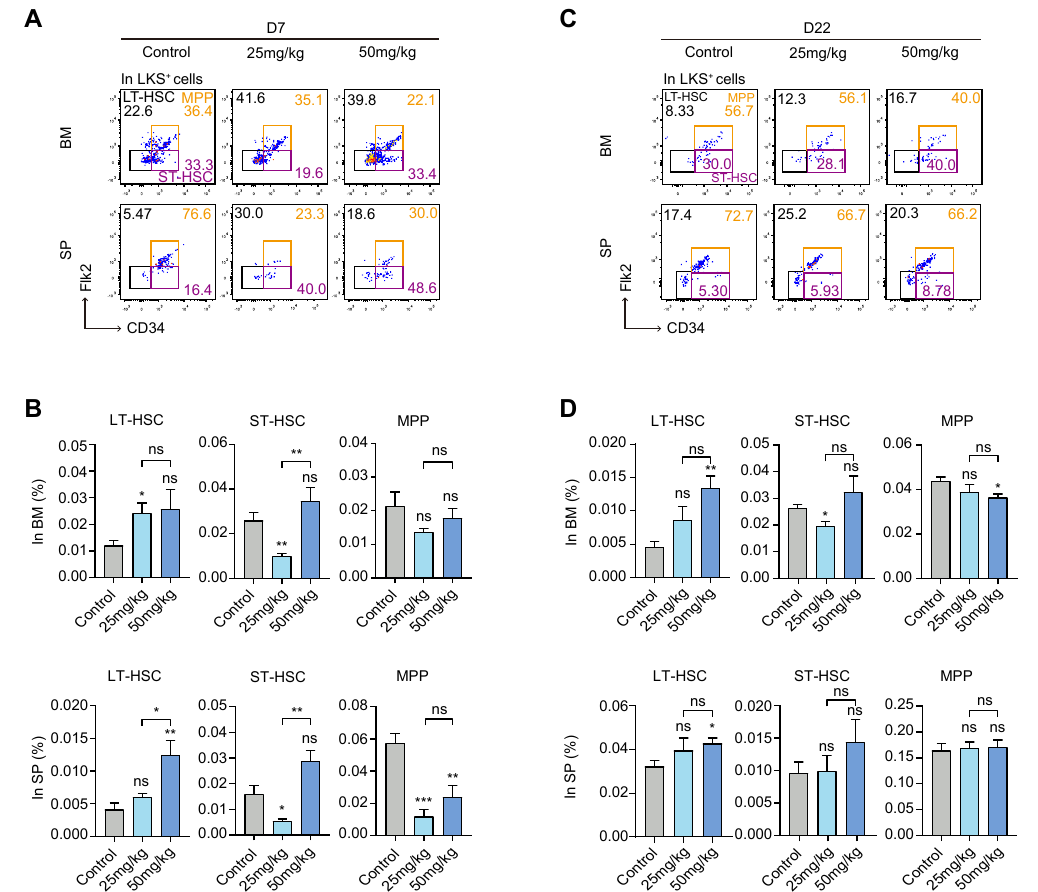
Figure 2. Effects of S63845 treatment on the hematopoietic stem/progenitor cells of CB6F1 mice. ( A ) Representative FACS profiles of LT-HSC, ST-HSC, and MPP subpopulations in BM and SP LKS + cells of control and S63845-treated mice on day 7. Control, n = 5; 25 mg/kg, n = 5; 50 mg/kg, n = 4. ( B ) Percentage of LT-HSC, ST-HSC, and MPP populations in BM (upper panel) and SP (lower panel) LKS + cells, as described in ( A ). Control, n = 5; 25 mg/kg, n = 5; 50 mg/kg, n = 4. ( C ) Representative FACS profiles of LT-HSC, ST-HSC, and MPP subpopulations in BM and SP LKS + cells of control and S63845-treated mice on day 22. Control, n = 6; 25 mg/kg, n = 5; 50 mg/kg, n = 4. ( D ) Percentage of LT-HSC, ST-HSC, and MPP populations in BM (upper panel) and SP (lower panel) LKS + cells, as described in ( C ). Control, n = 6; 25 mg/kg, n = 5; 50 mg/kg, n = 4. All data represent the means ± SEM compared with control unless otherwise specified. * p < 0.05, ** p < 0.01, *** p < 0.001, and ns = not significant according to two-tailed unpaired Students’ t -test. LT-HSC: long-term hematopoietic stem cell; ST-HSC: short-term hematopoietic stem cell; MPP: multipotent progenitor; LKS + : Lin − c-Kit + Sca-1 + . 3.3. S63845 Affects Extramedullary Myeloid Hematopoiesis in